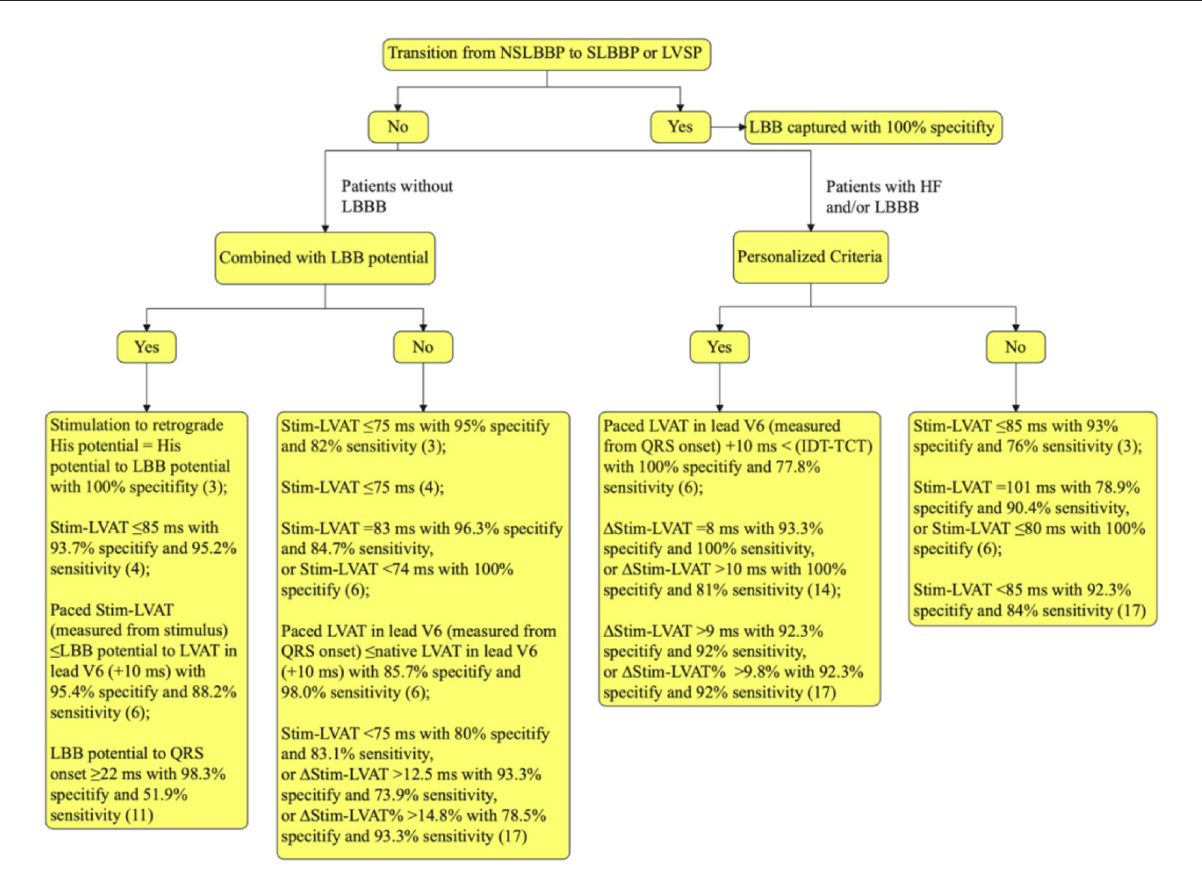
FIGURE1 Flowchart for confirming LBB capture. LBB, left bundle branch; LBBB, LBB block; NSLBBP, non-selective LBB pacing; SLBBP, selective LBB pacing; LVSP, left ventricular septal pacing; HF, heart failure; Stim-LVAT, stimulus artifact to left ventricular activation time in lead V5 or V6;